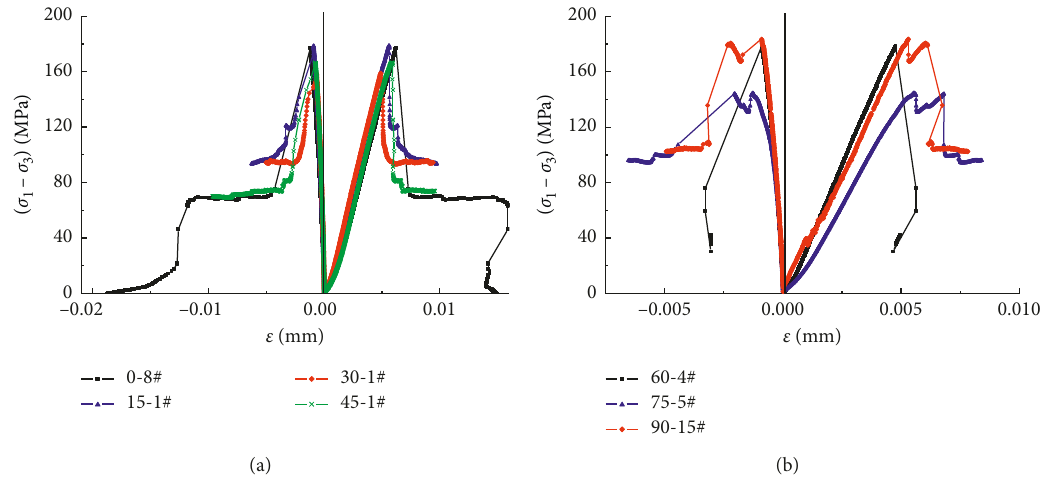
Figure 7: The stress-strain curves of the specimens: confining pressure of 10MPa.